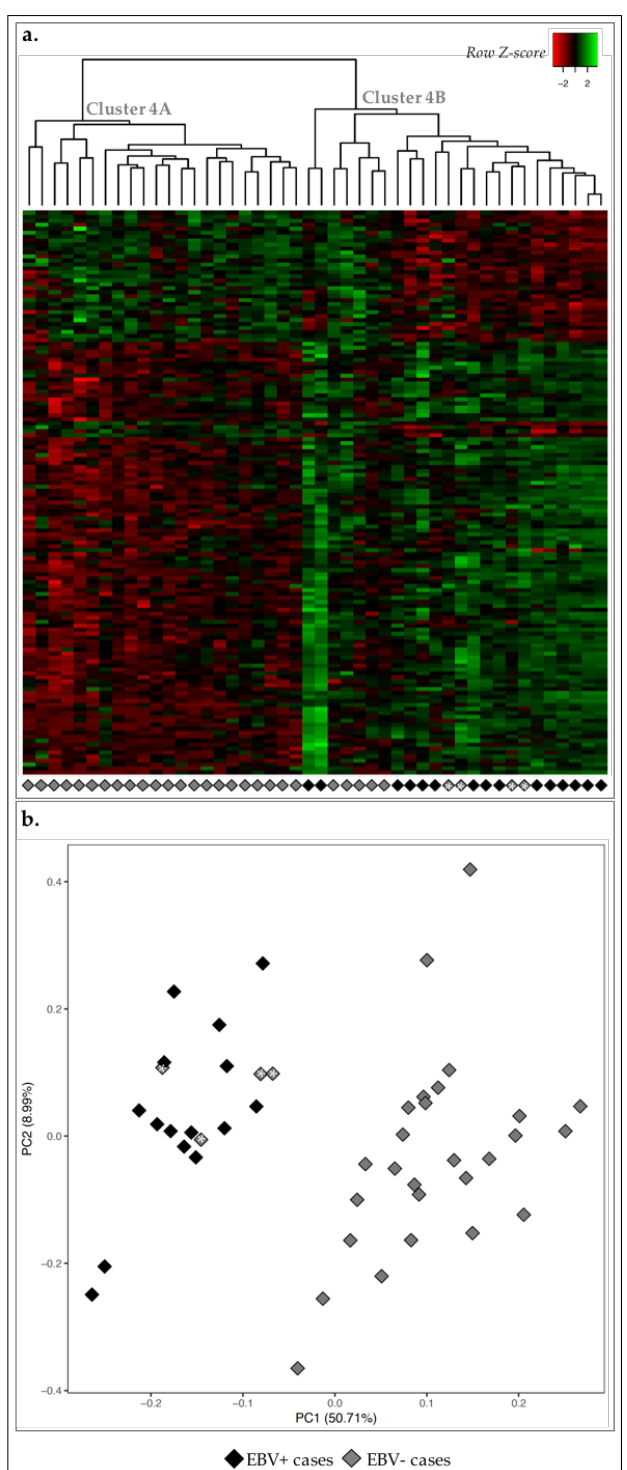
Figure 4. Expression profile of the 46 GC cases for 142 DE-genes between EBV positive and negative cases. ( a ) Heatmap for the expression of the 142 DE-genes (log 2 and Z -score scaled). Indicated are two main clusters: A and B. ( b ) PCA for principal components 1 and 2 for the 46 GC samples. Black diamonds correspond to EBV+ cases ( n = 15) and white diamonds to EBV − cases ( n = 31). Diamonds with asterisk for correspondence between panels ( a ) and ( b ) and described in the main text.